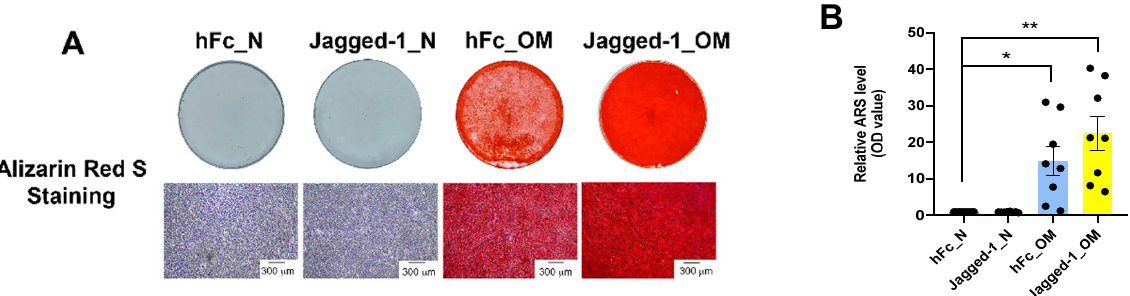
Figure 2. Indirect immobilisation Jagged-1 (Jagged-1) induced mineralisation in hDPSCs. On day 14, the mineralisation was examined by ( A ) ARS staining. ( B ) The relative value of the eluted ARS stain was measured at an absorbance of 570 nm. Asterisks indicated a statistically significant difference compared with the hFc_N. * p ≤ 0.05 and ** p ≤ 0.01. 2.3. Subcellular Fractionation Showed the Existence of Matrisome Proteins The total protein in each compartment was approximately 3000 proteins under all culture conditions. The proteome analysis of all cellular compartments , including cytosol, membrane, nucleus, and cytoskeletal , demonstrated that matrisome proteins were found